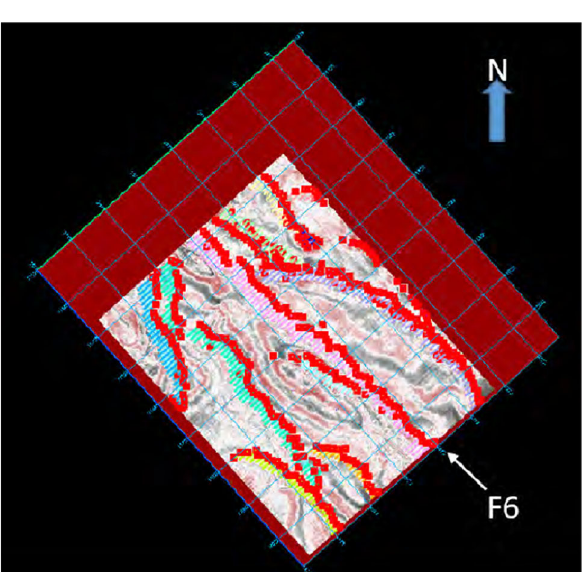
Fig. 6 Time slice at 1500 ms showing NW–SE-trending